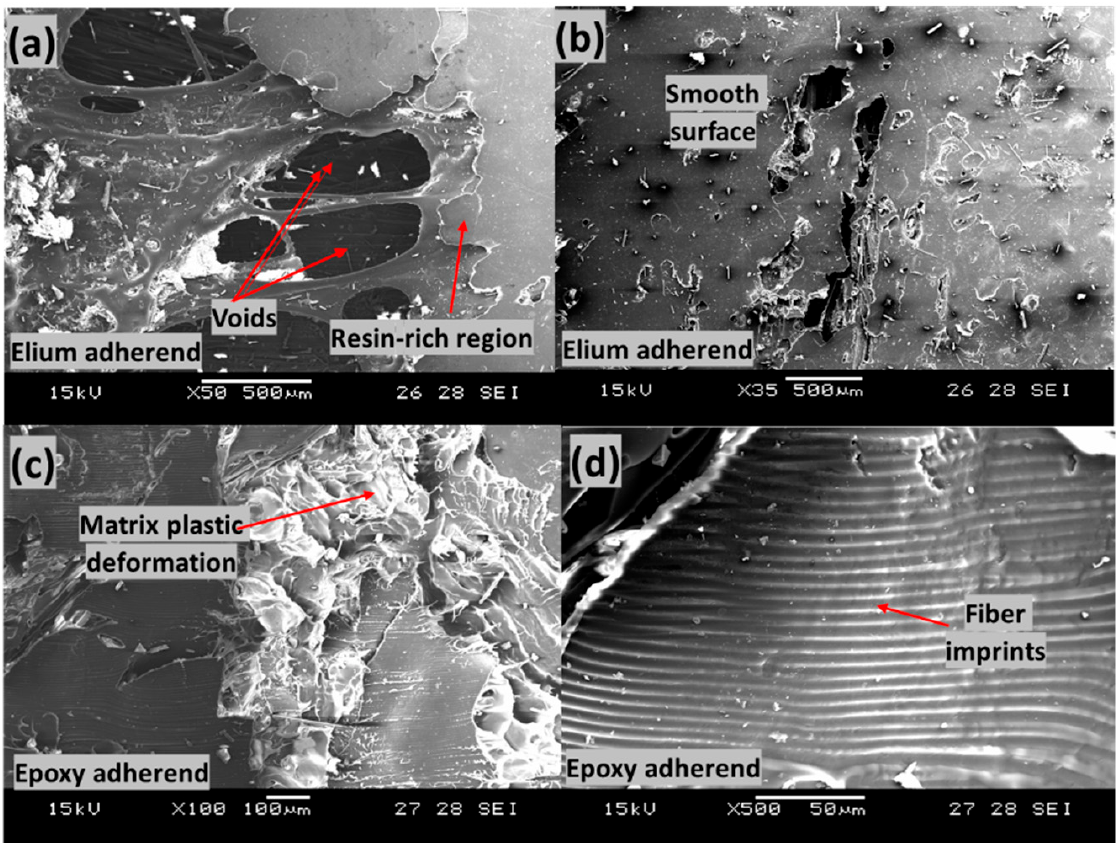
Figure 20. Scanning Electron Microscope fractography of EL-EP(Elium ® -Epoxy)_0.25 with minimum LSS. ( a , b ) Elium adherend and ( c , d ) epoxy adherend.